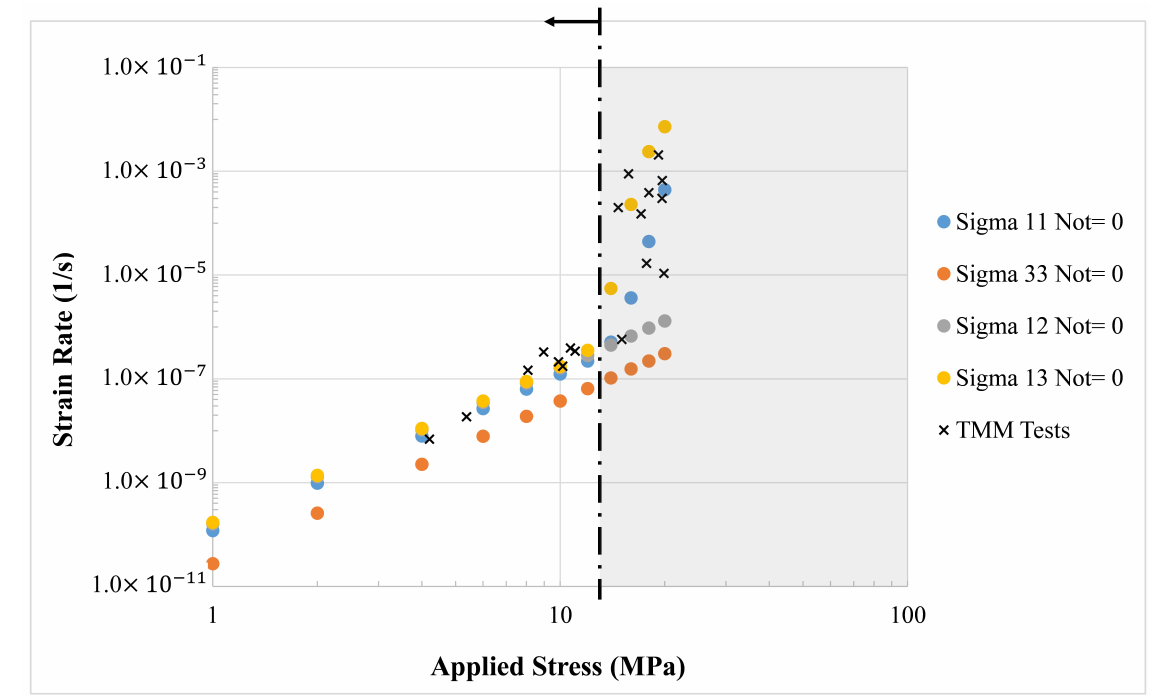
Figure 2. Strain rates along the loading directions calculated from the CV model. Table 1. Parameters for Hill–Norton models. Table 1. Parameters for Hill–Norton models.